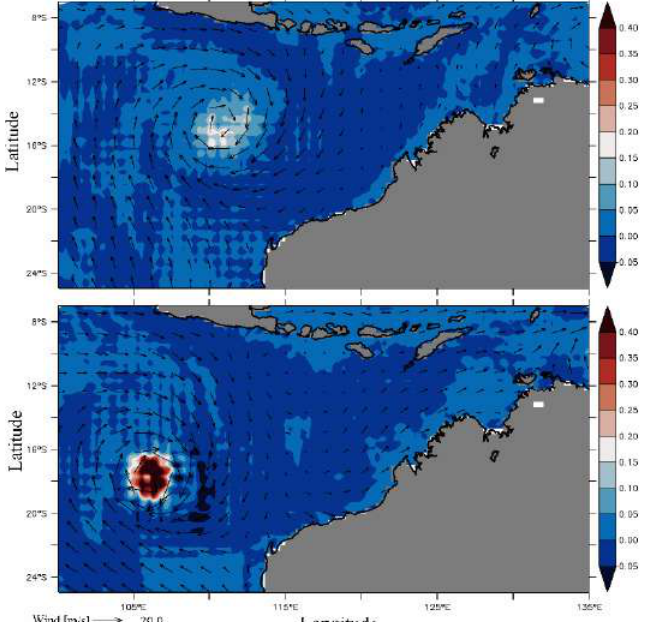
Fig. 8: Distribution of EPV [color in x10 -5 m/s] during: (a) Cyclone Marcus category 4 (21 March 2018), (b) Cyclone Marcus category 5 (22 March 2018)